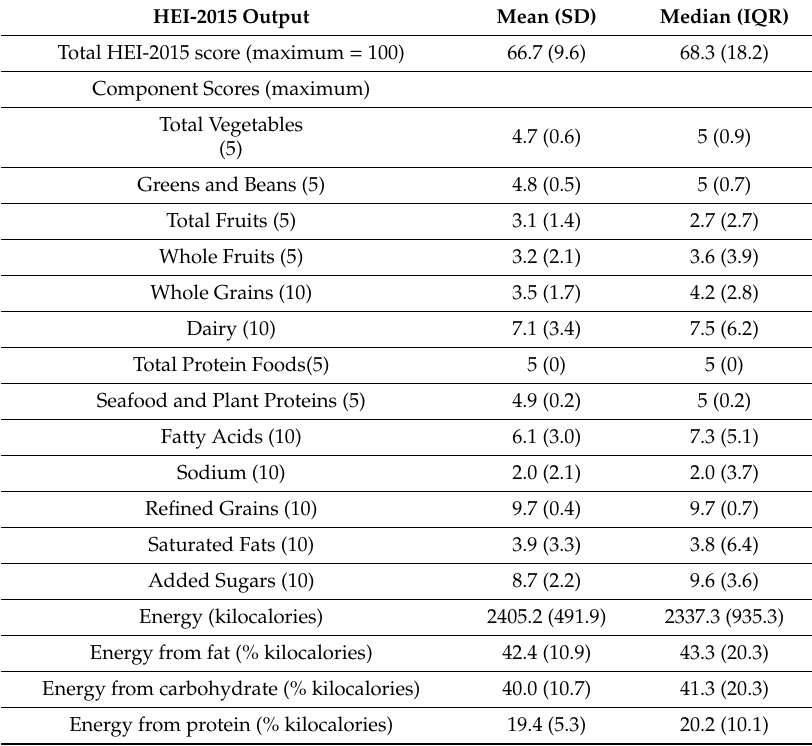
Table 2. Usual dietary intake data of participants ( n = 4).